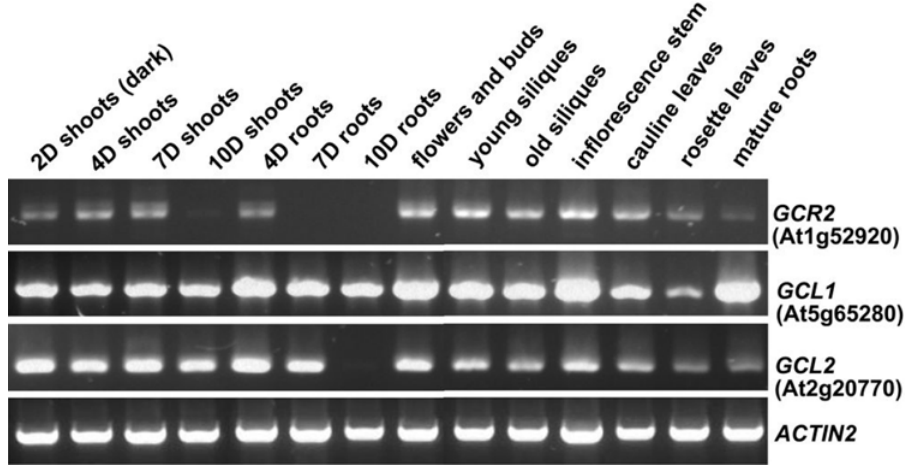
Figure 1. RT-PCR analysis of the expression of GCR2 , GCL1 and GCL2 genes in various tissues and organs of young seedlings and mature plants. PCR was performed with 38 cycles. The expression of ACTIN2 was used as a control.